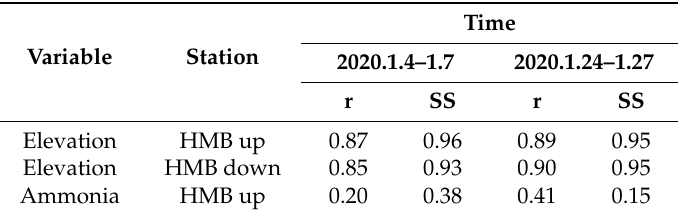
Figure 2. Comparison between simulation results and observed data. Water surface elevation in the upstream ( a , b ) and downstream ( c , d ) part of the HMB tide gate were plotted in the first and second row. Fluctuations of ammonia were shown in the last row ( e , f ). Time series of neap and spring phases were arranged in the left and right panel, respectively. Table 1. Statistical summary of the di ff erence between observation and results of the simulation, using correlation coe ffi cient (r) and model skills